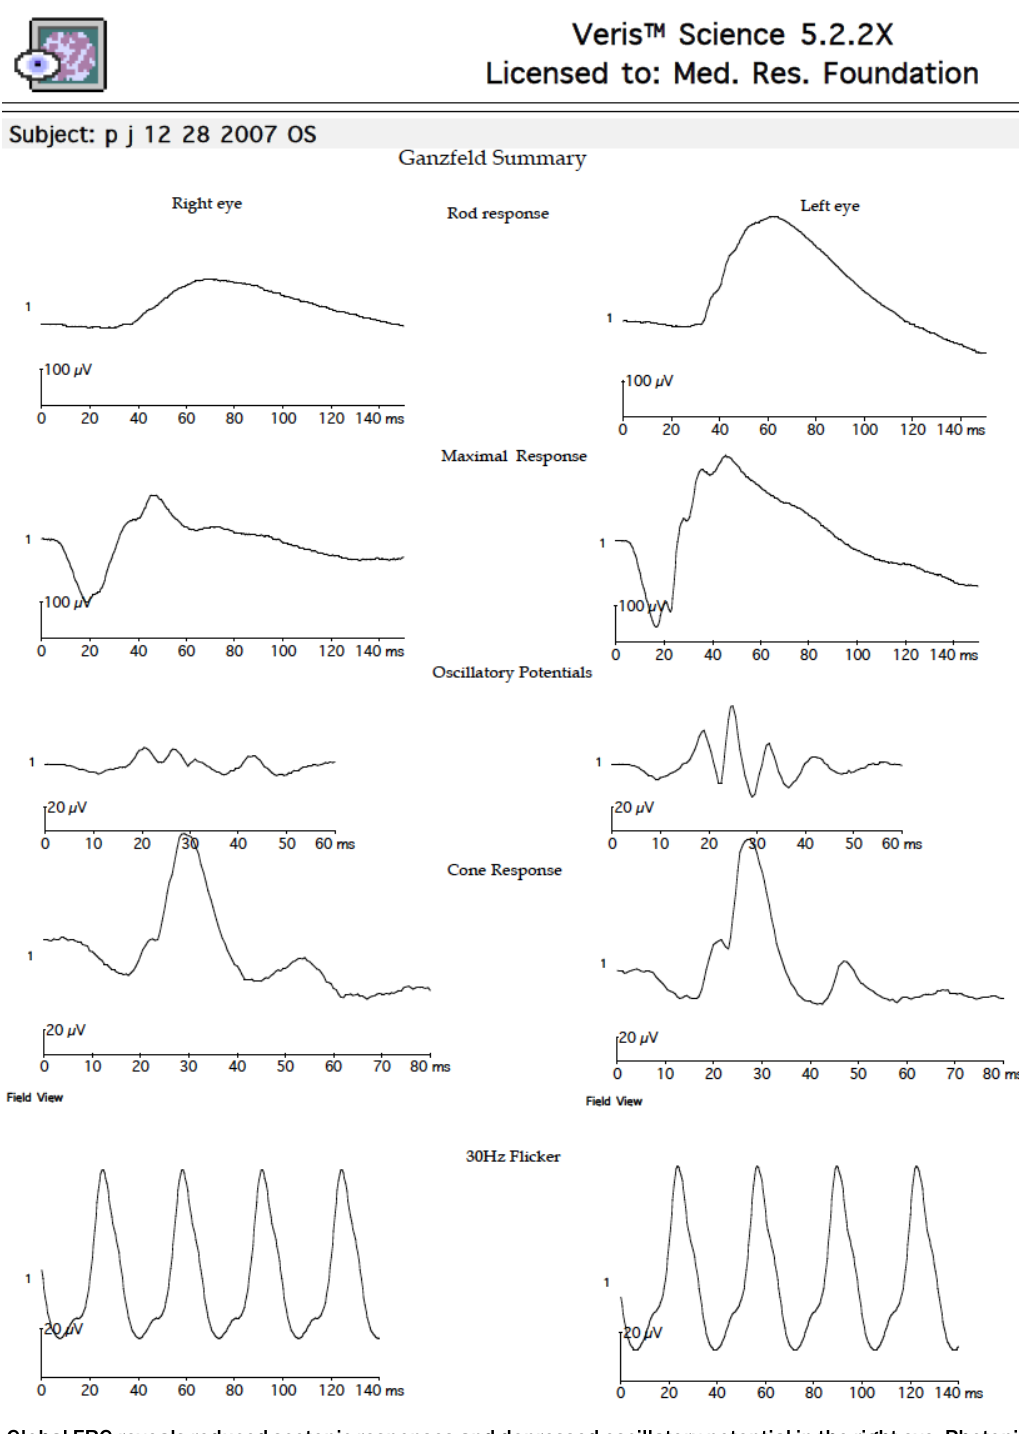
Figure 4: Global ERG reveals reduced scotopic responses and depressed oscillatory potential in the right eye. Photopic response was